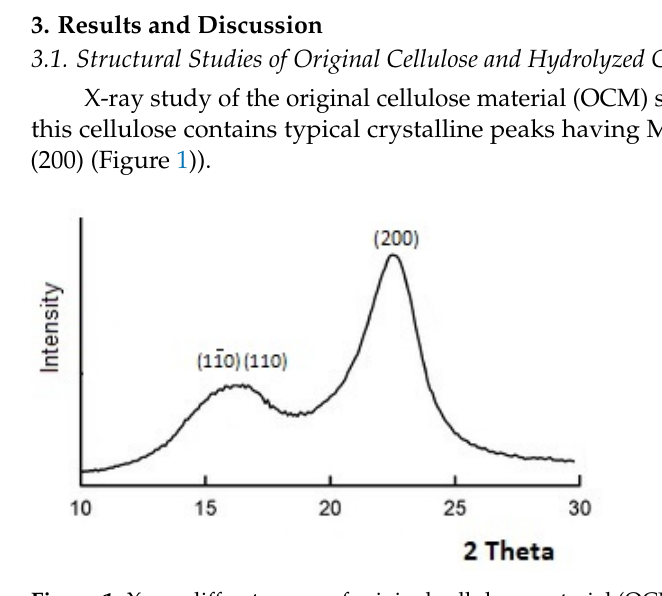
Figure 1. X-ray diffractogram of original cellulose material (OCM).